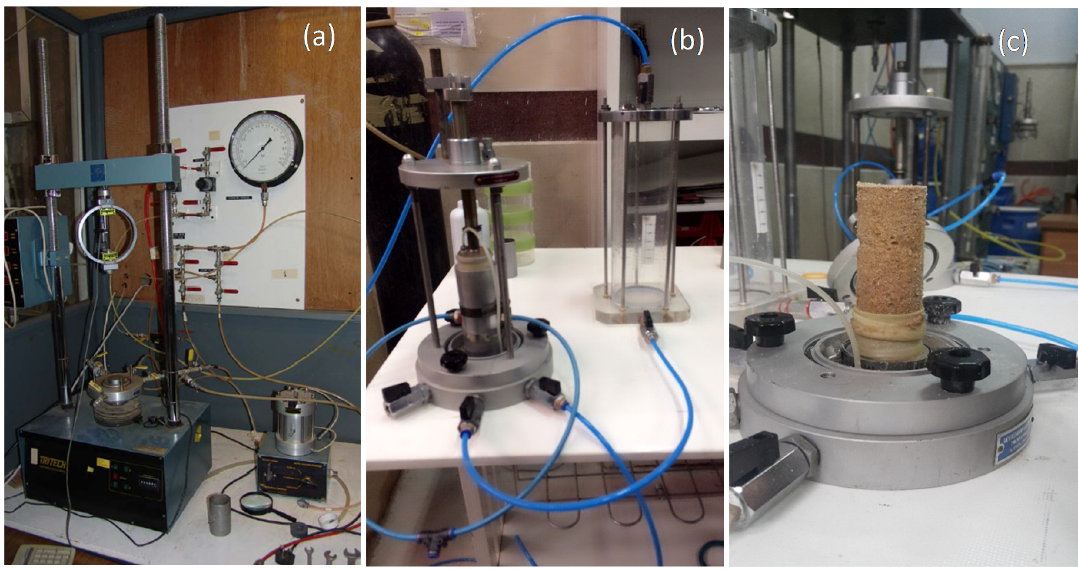
Figure 3. Set up for preparation of grouted specimens and triaxial compression testing: ( a ) monotonic triaxial apparatus; ( b ) remolded specimen in double-split-type mold under small 15 kPa vacuum pressure applied at two points around perimeter; ( c ) NS-stabilized test specimen.